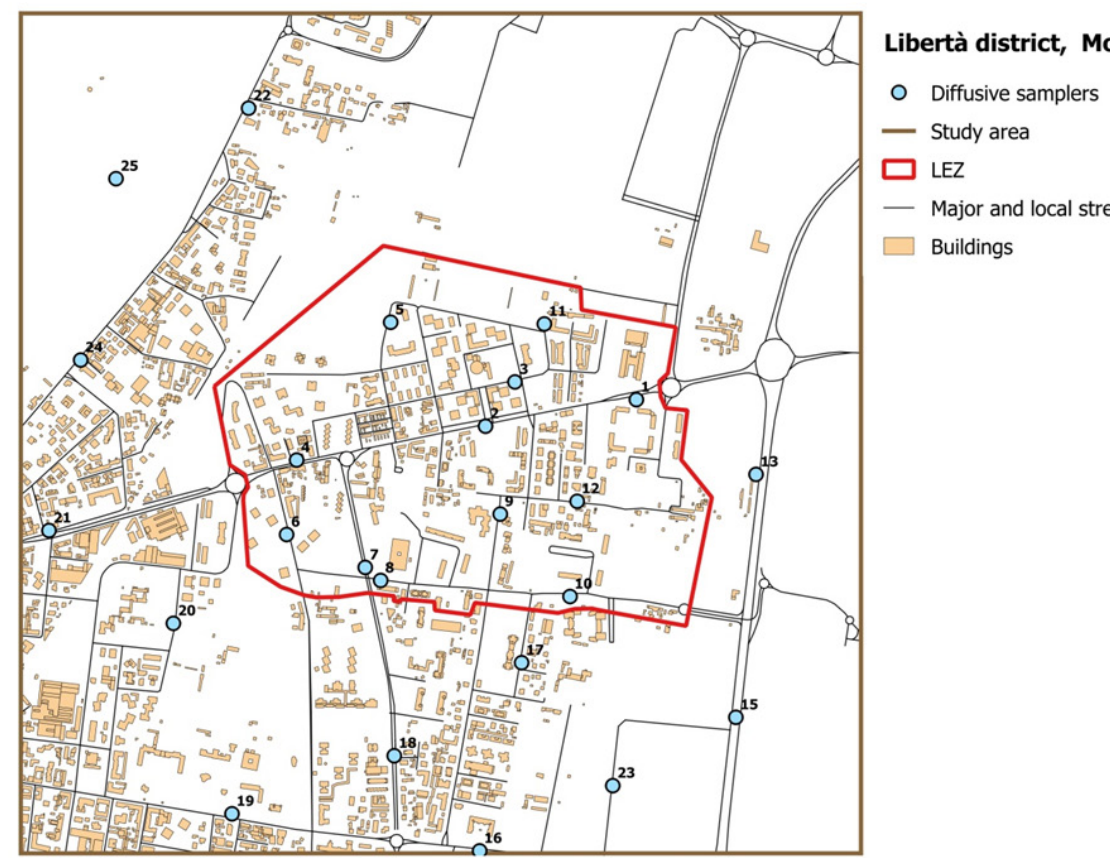
Figure 5: Benzene and toluene diffusive